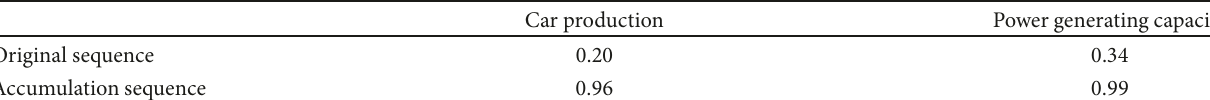
Table 3: The Hurst exponent value of two indexes.